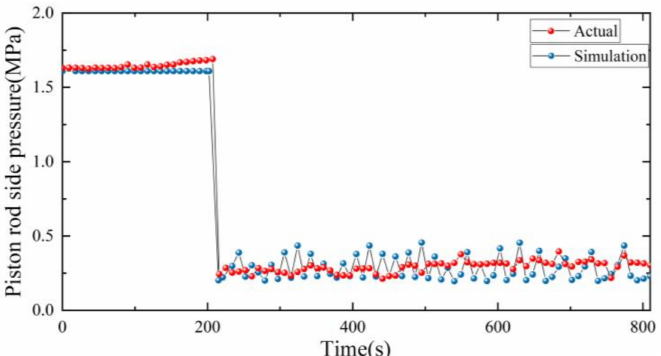
Figure 13. Piston rod side pressure when